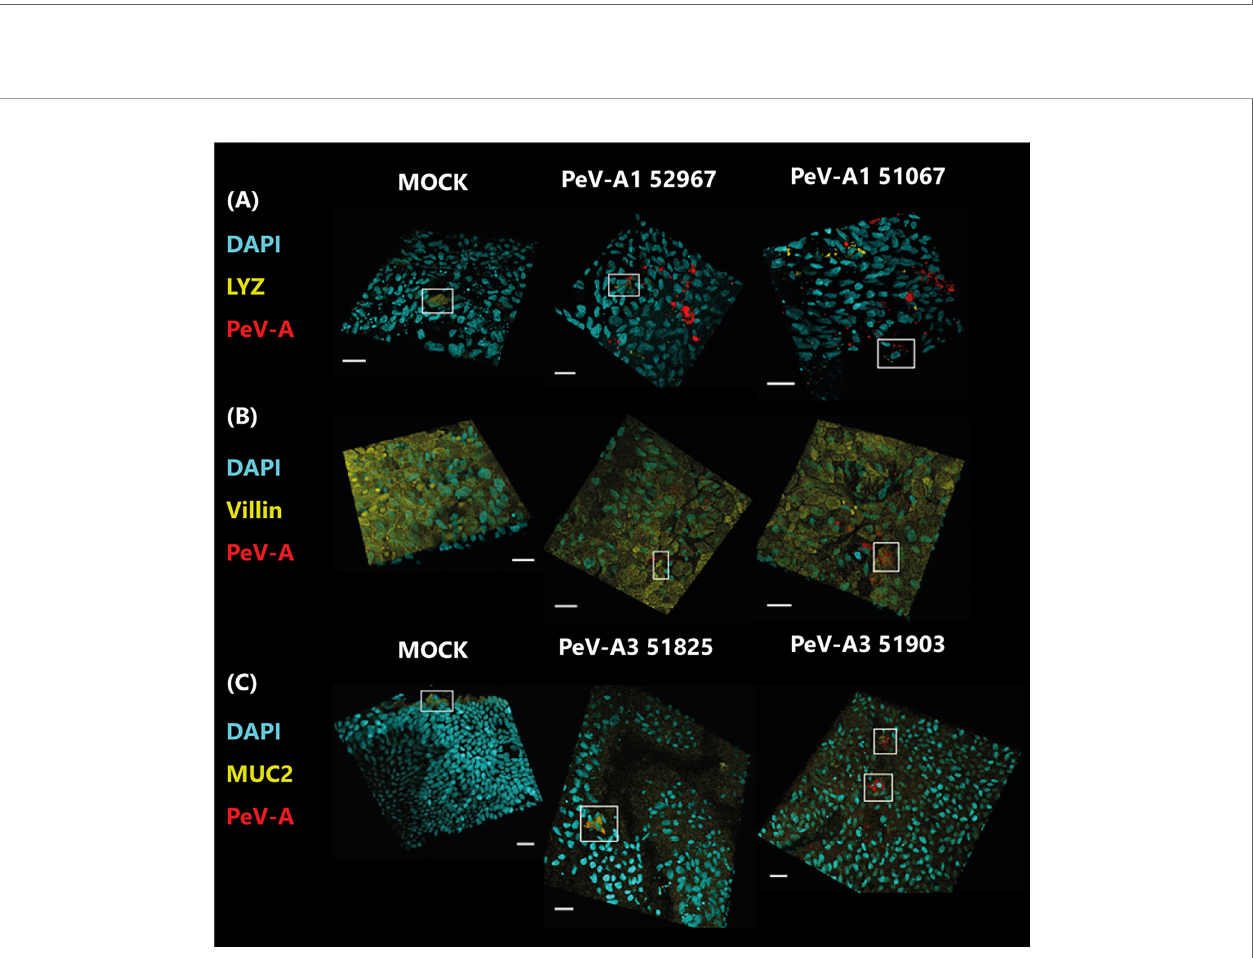
FIGURE 6 | Confocal images of infected cultures with clinical isolates of PeV-A1 and PeV-A3. In panel (A) , cultures were stained with Paneth cell marker (LYZ) in yellow and PeV-A antibody in red; in panel (B) , they were stained with enterocyte marker (villin) in yellow and PeV-A antibody in red, and in panel (C) , cultures were stained with goblet cell marker (MUC2) in yellow and PeV-A antibody in red. In all cases, nuclei were stained with DAPI in cyan. Scale bars in white represent 20 µm, and the boxes indicate positively stained cells for the cell marker in the MOCK cases and for viral and cell marker staining in the infected